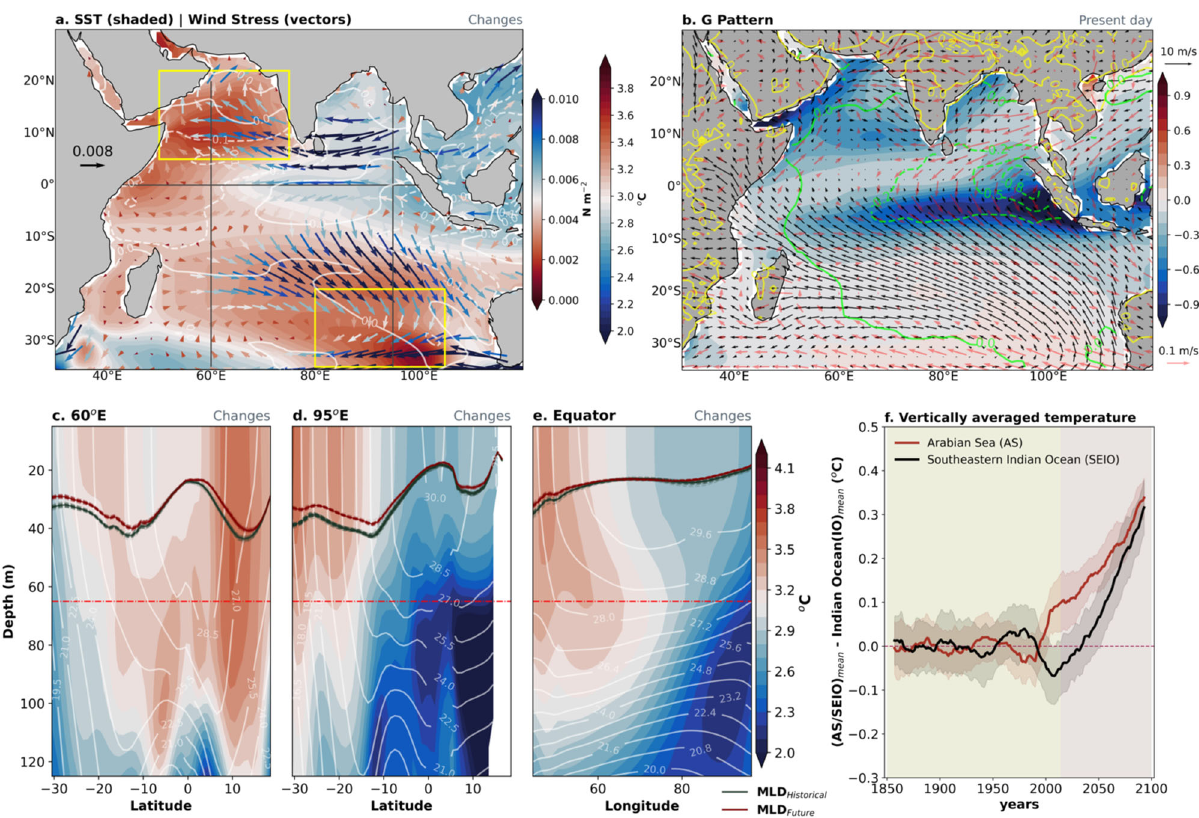
Fig. 1 | Projected mean-state changes of ocean temperature and present-day air-sea interaction in the Indian Ocean (IO). Ensemble mean changes of ( a ) sea surfacetemperature(SST) (°C, shaded) and surface wind stress (N/m 2 , vectors) for the fi rst50membersofCESM2-LE.Themeanstatechangesarecalculatedbytaking the ensemble mean difference between the future (2080 – 2100) and the historical (1980 – 2000) periods. The white contours represent the ensemble standard deviation of the SST changes. The yellow boxes over the Arabian Sea (AS) (5°N:22°N, 50°E:75°E) and southeastern IO (SEIO) (35°S:20°S, 85°E:105°E) indicate the preferential mean-state warming region in the IO in the future climate. Ensemble mean of ( b ) G pattern (shaded), climatological winds (black arrows), anomalous winds (red arrows), and anomalous surface temperature over land (yellow contours) during the period 1980 – 2000. G is multiplied by a factor of 10 3 andanomaliesarerelativetothe1850 – 2014baselineperiod.Thegreencontoursin ( b ) shows the G pattern in the observations during the period 1980 – 2000 and